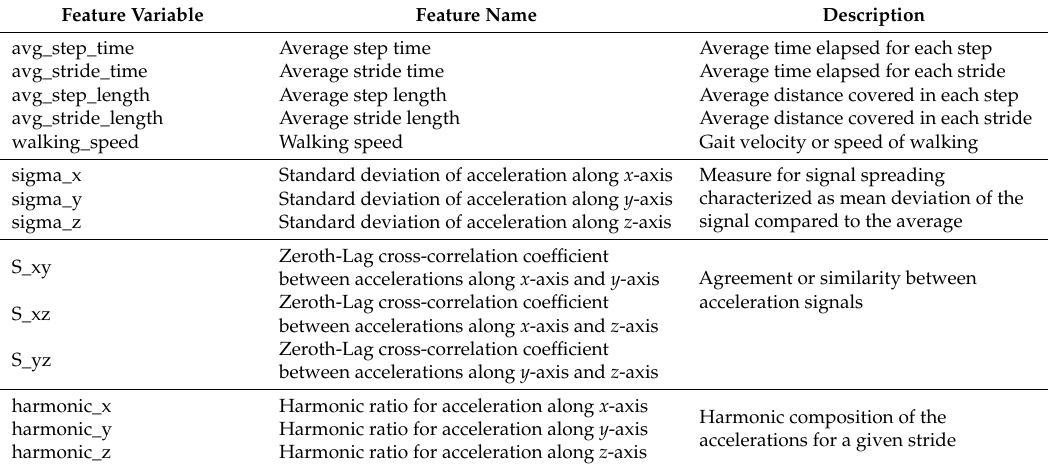
Table 1. Computed features and their brief